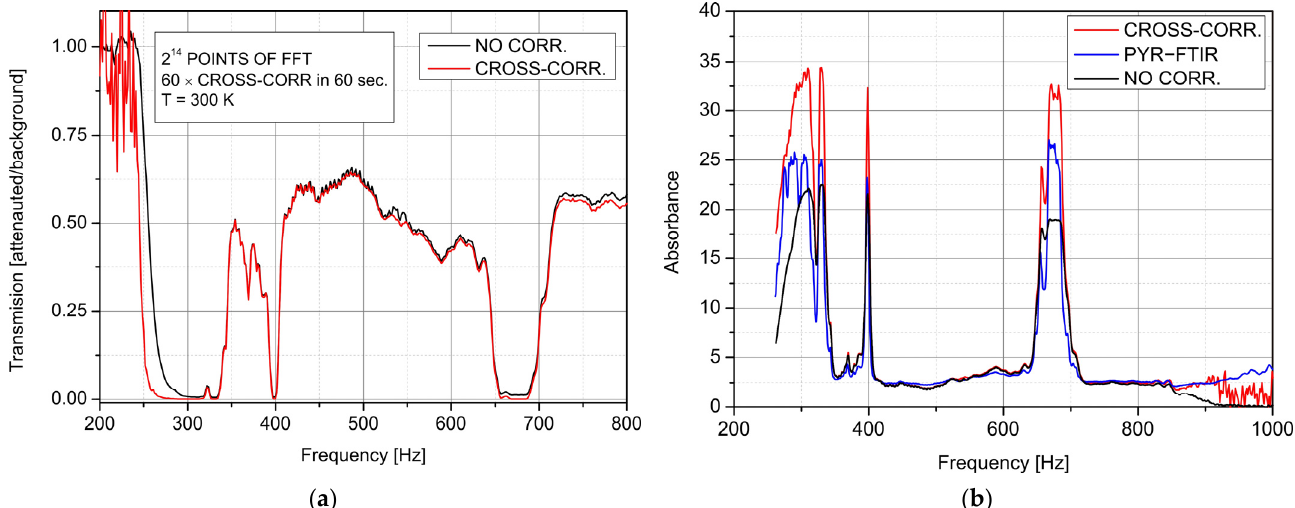
Figure 10. Comparison of the foil spectral transmission registered with one- (NO CORR.) and two-(CROSS-CORR.) detection channels. ( a ) The foil absorbance determined with the standard pyroelectric detection module (PYR–FTIR) and designed sensor in a two-channel (CROSS-CORR.) and a single-channel (NO CORR. ) configuration ( b ).